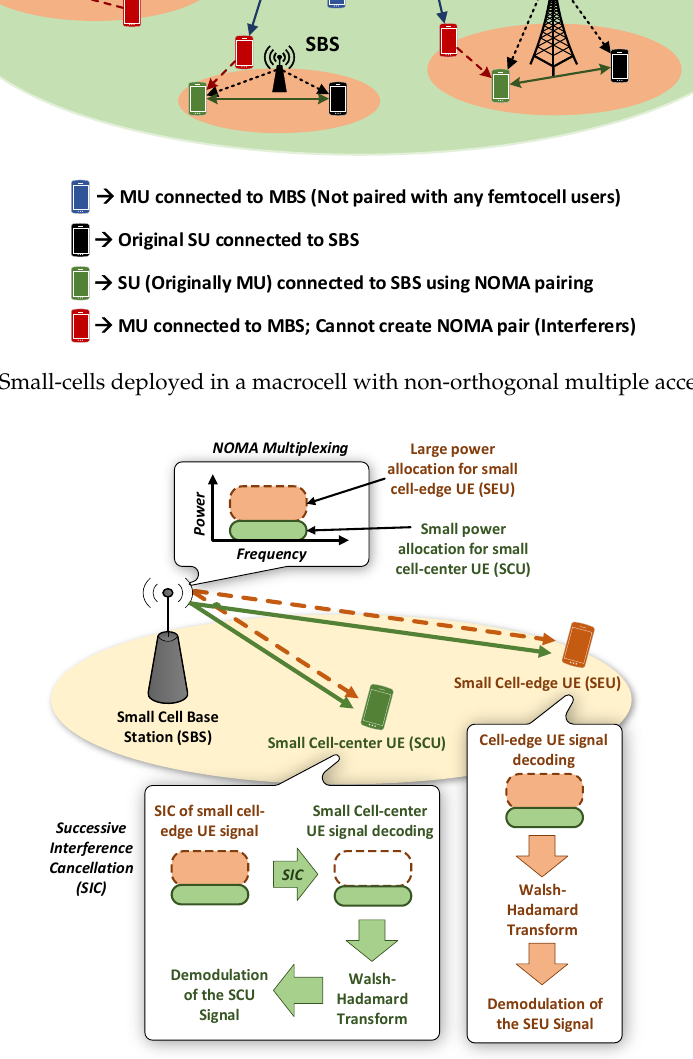
Figure 3. Walsh–Hadamard transform (WHT)-NOMA in a Figure 3. Walsh – Hadamard transform (WHT)-NOMA in a small-cell.